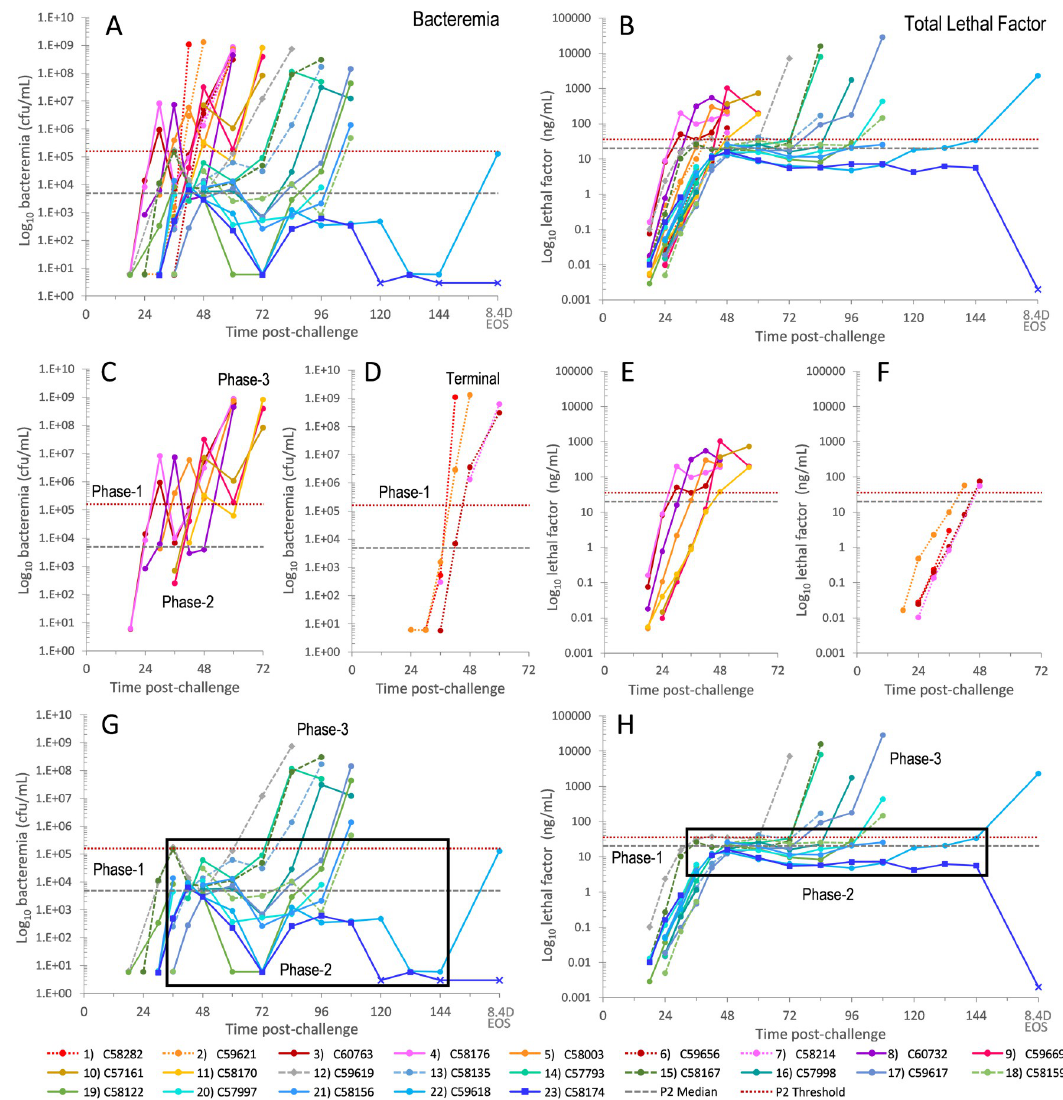
Fig 2. Kinetics of bacteremia and lethal factor in 23 cynomolgus macaques. Bacteremia (Bact) in (cfu/mL) (A) and total lethal factor (LF) in (ng/mL) (B) over the course of infection. 11 animals had higher early bacteremia/toxemia and shorter survival (fast progression) (red/orange/purple lines), and 11 animals had lower early toxemia and longer survival (slow progression) (aqua/green lines), and one survivor with low early toxemia (blue line, square symbols). Triphasic kinetics: initial rise (phase-1), plateau/decline (phase-2), and final rise to terminal (phase-3). Bacteremia and LF in 7 animals with fast triphasic kinetics (C) and (E) and 4 animals with monophasic kinetics, a single rapid rise, (D) and (F), respectively. Bacteremia and LF in 11 animals with slow progression and survivor, (G) and (H), respectively. Final time points for 22) C59618 that died at 8.4 days (8.4D) and the survivor, 23) C58174, at the end-of-study (EOS, 14-days) are not to scale. For bacteremia (bact), non-quantifiable results of low positive were assigned a value of 6 and negative at 3 cfu/mL. Bacteremia and LF below the limit of detection (x-symbol). Boxes represent the broad range of bacteremia in phase-2 (G) and narrow range of LF levels during phase-2